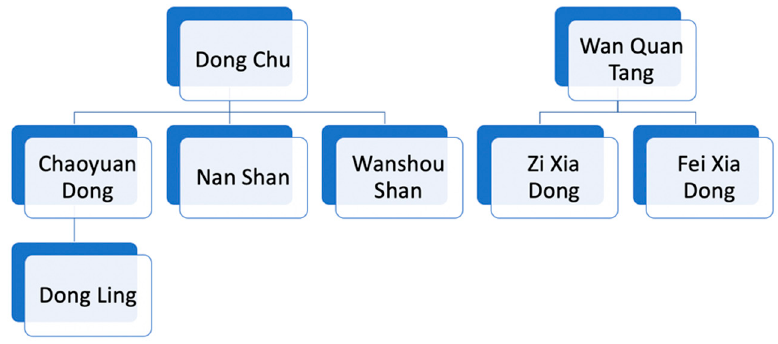
Figure 4. The main sect branch of “ Xiantian Dao” in Singapore.